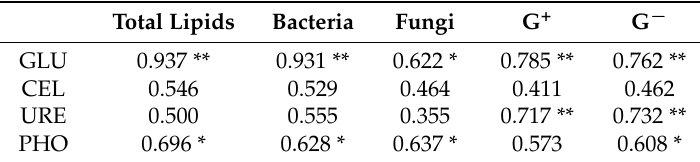
Table 5. Correlation coefficients between soil microbial community and enzyme activity in the organic layer. Total Lipids